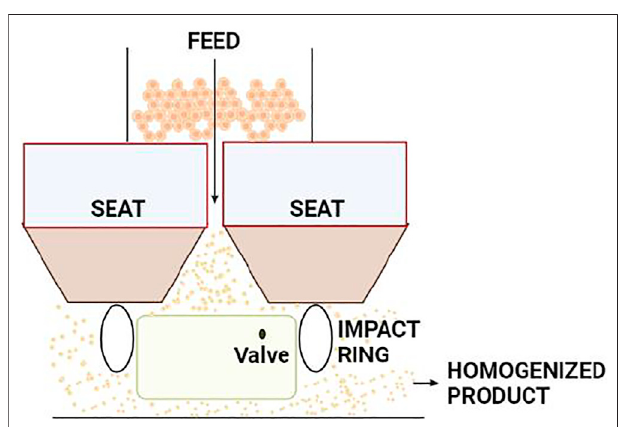
FIGURE 5 | Micro fl udizer